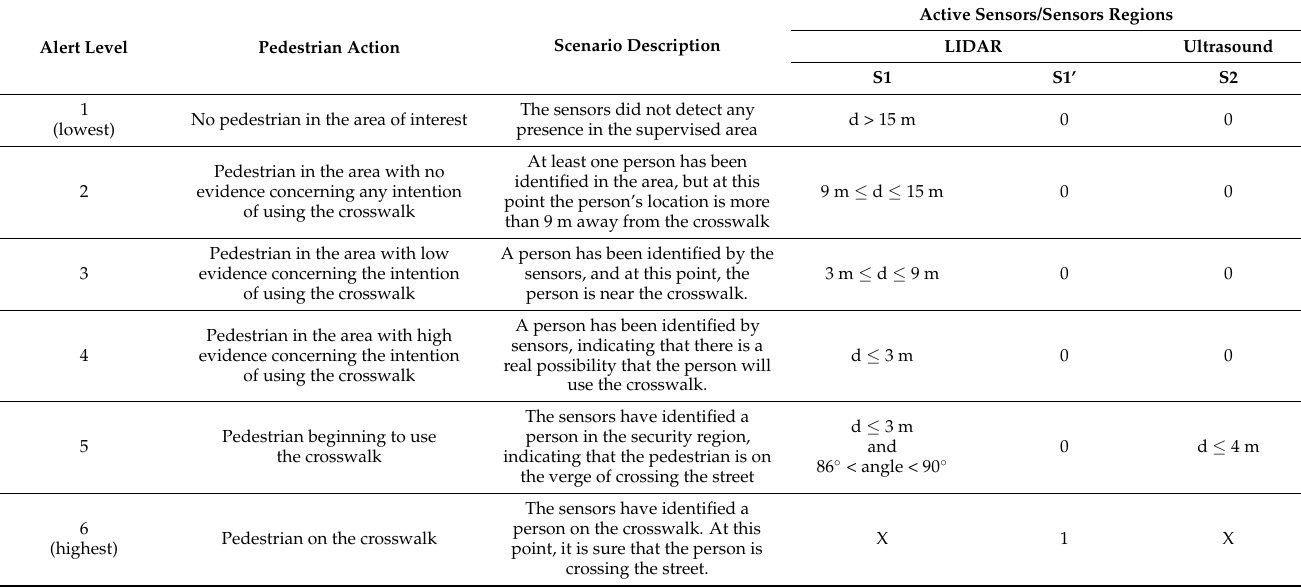
Table 4. Table defining the alert level concerning the occupied areas with pedestrians near the